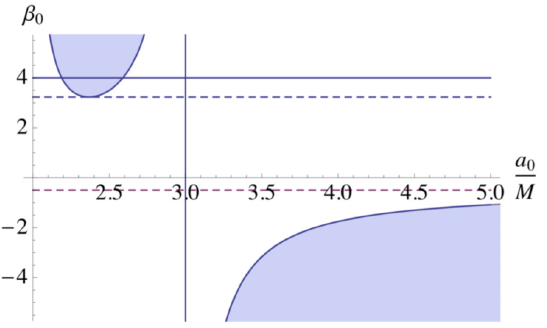
Figure 8. If β 0 is given, one knows the range of a 0 for the stable static throat solution. Region a 0 < 2 M is unphysical since such region does not exist in the wormhole. The upper broken line is β 0 = ( 3 + while lower is β 0 = − 1/2. Shaded regions correspond to stable regions. We draw the horizontal line with β 0 = 4 for an example. In this case, wormhole can be stable if 2.19 M < a 0 < 2.59 M